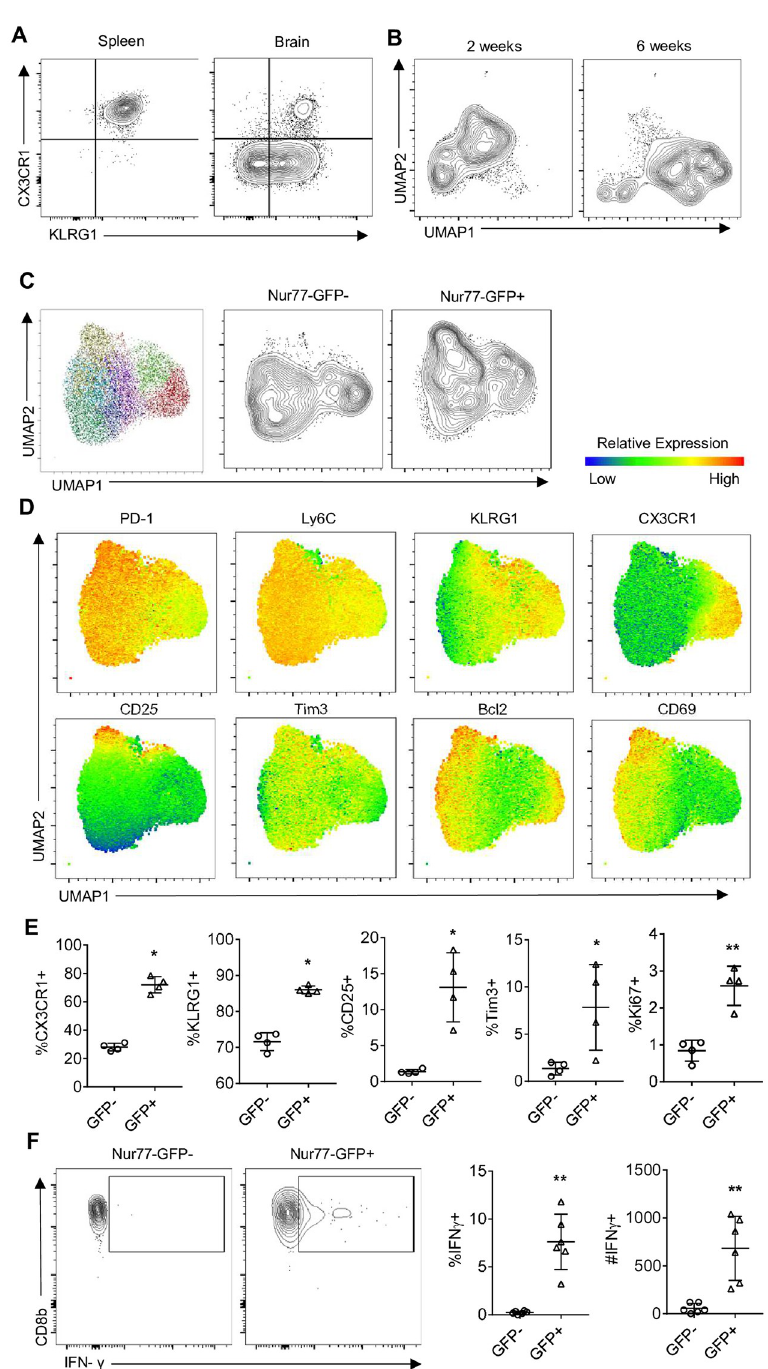
Fig 7. Infection induced phenotype and function of CNS T . gondii specific CD8 + T cells during chronic infection. (A) High dimensional flow cytometry with UMAP of OT-I from brains of mice infected with T . gondii -OVA at 14 dpi and 6 weeks post infection (representative of N = 4 mice per tissue). (B) Phenotype of OT-I in spleen and brain of T . gondii -OVA infected mice 6 weeks post infection (N = 4 mice per timepoint). (C-E) High dimensional flow cytometry with UMAP and Phenograph clustering was performed on brain OT-I at 6 weeks post infection (N = 4 mice). (C) UMAP segregation of clusters of all OT-I (left), Nur77-GFP + OT-I (center), and Nur77-GFP + OT-I (right). (D) Heatmap of marker expression from UMAP. I Frequency of marker positive OT-I within Nur77-GFP - or Nur77-GFP + OT-I fraction. (F) Endogenous levels of IFN- γ expression in Nur77-GFP- and Nur77-GFP+ OT-I following 4-hour culture with protein transport inhibitor (N = 6 mice). P values based on Paired T-test � p < 0.05 �� p < 0.01; error bars indicate